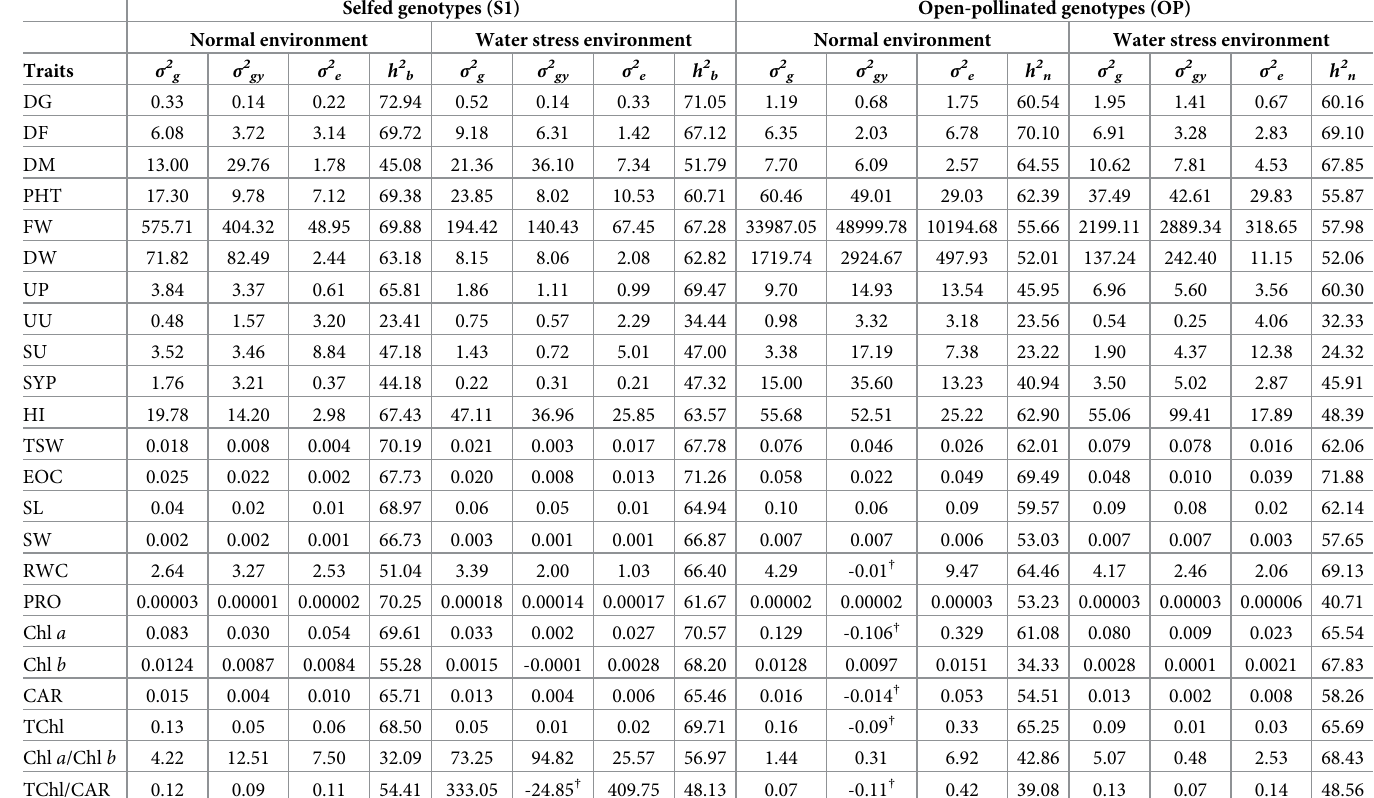
Table 5. Estimates of variance components, broad-sense heritability ( h2b ) of S1 population, and narrow-sense heritability ( h2n) of OP population for the evaluated traits of fennel under two moisture conditions (normal and water deficit) during 2019–2020. Selfed genotypes